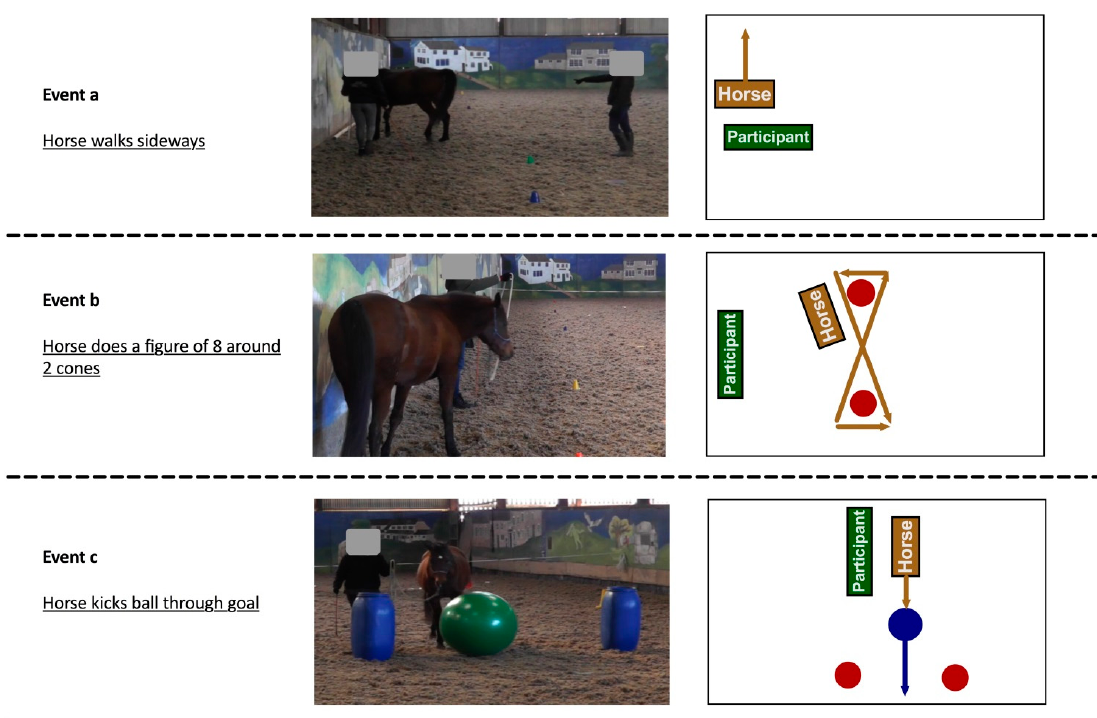
Figure 2. Examples of more advanced manoeuvres with horse under the direction of the participant.